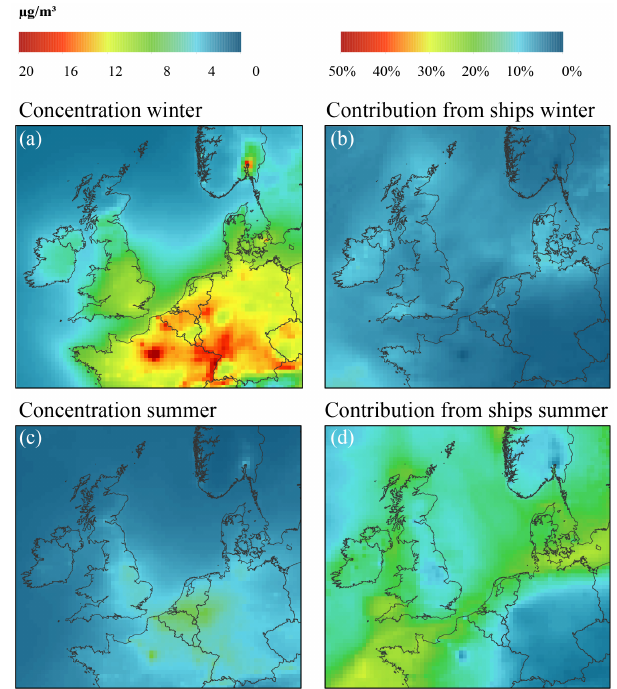
Figure 13. PM 2 . 5 in summer and winter and the relative contribu- tion of ship emissions.